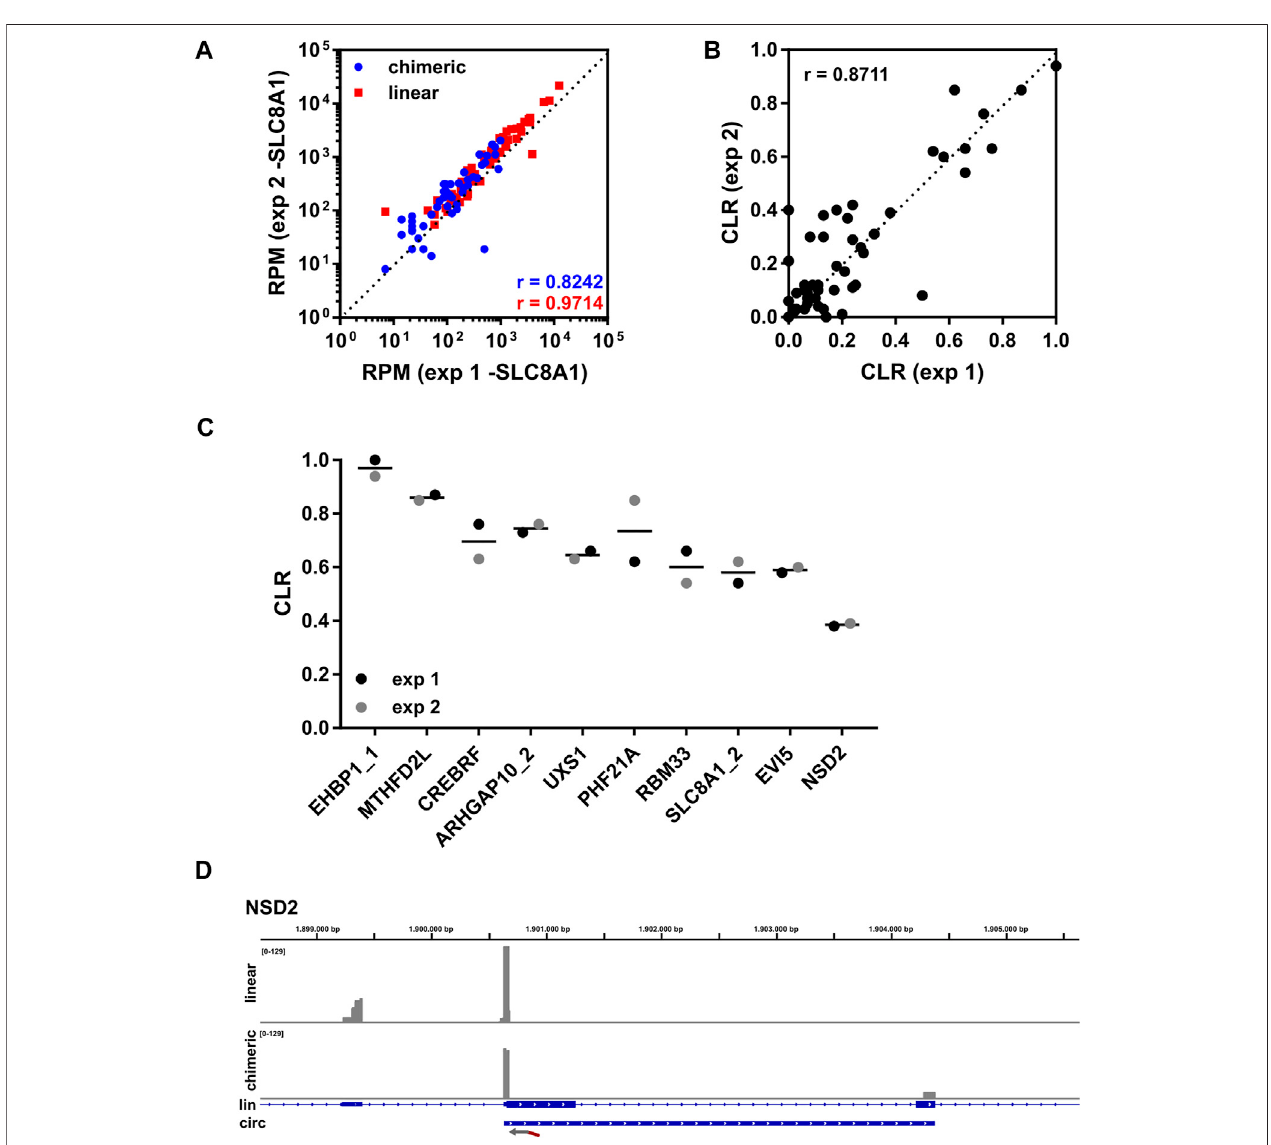
FIGURE 2 | Lexo-circSeq analysis of THHR. (A) Correlation of RPM (uniquely mapped reads) for chimeric (blue) and linear (red) reads from experiments 1 and 2 using 250 ng of total RNA as input. circSLC8A1 was excluded from this analysis. r = Pearson correlation coef fi cient. p < 0.001. (B) The CLR was calculated for all targetedcircRNAs. Correlationofexperiments 1and 2.r=Pearson correlation coef fi cient.p < 0.001. (C) CLRforthetop 10circRNAs withthehighestcircular-to-linear ratio. (D) Read coverage of the targeted region in NSD2 from exp2. Linear reads are shown in the upper panel, chimeric reads are shown in the lower panel. The exon structure ofthe NSD2mRNA and coordinates oftheconservedcircRNA are depicted below. Bothpanels werescaled toadatarange of0-129 reads. Thebinding site of the FSS primer is indicated by an arrow.